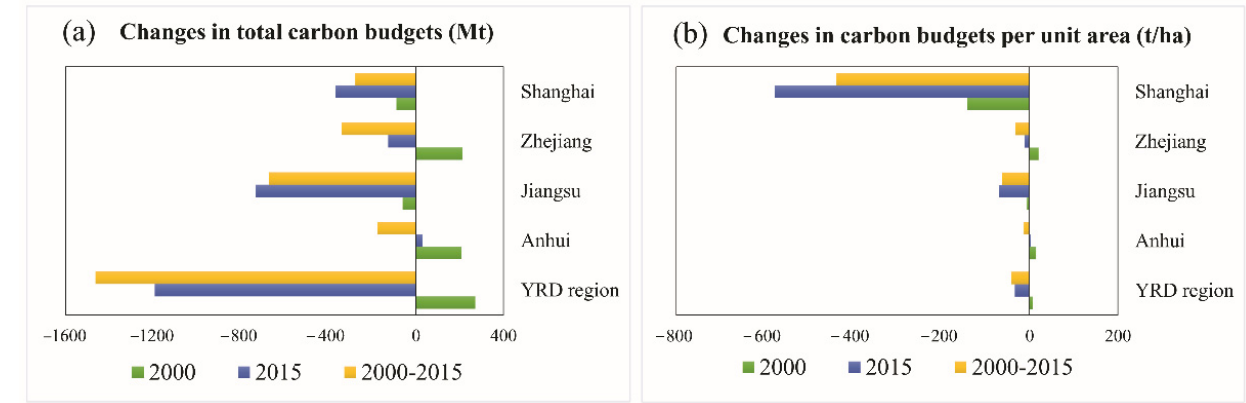
Figure 3. Quantitative changes in carbon budgets during 2000–2015.